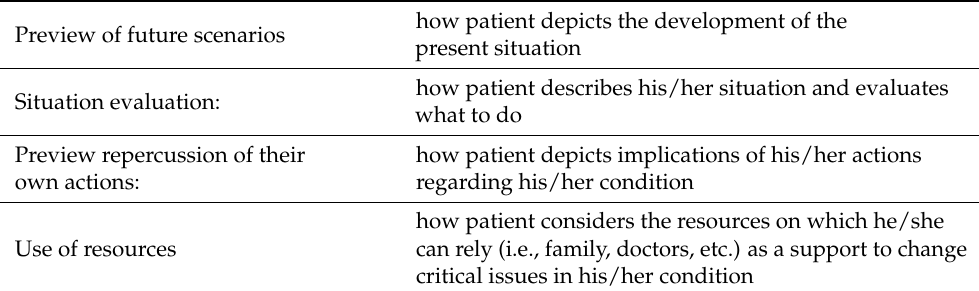
Table 1. Management Health Competences.